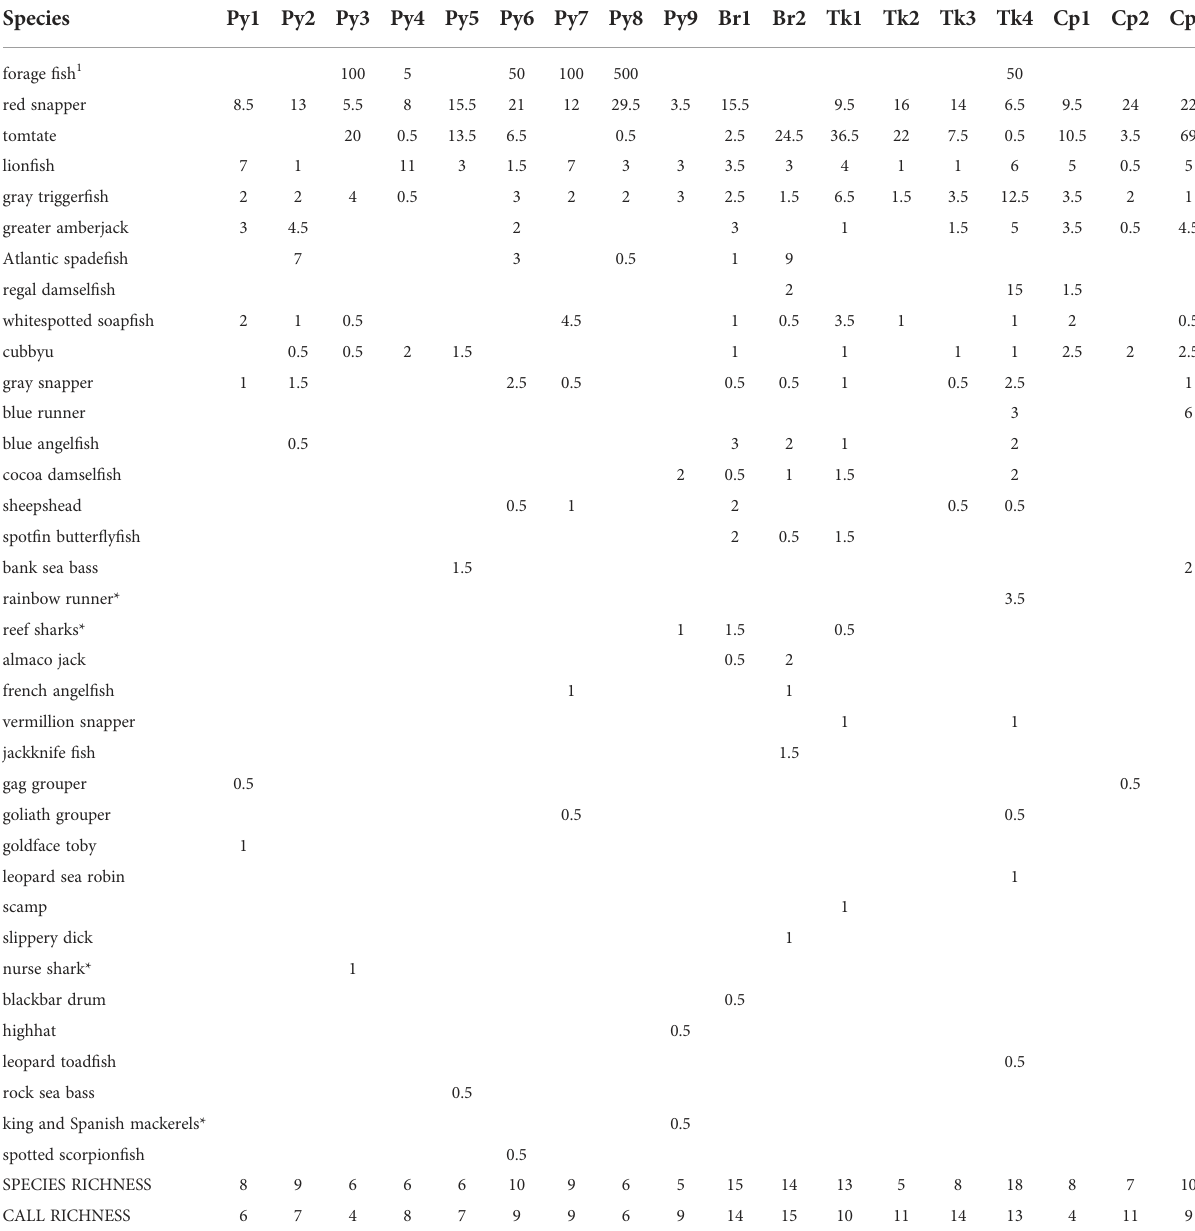
TABLE 2 Fish abundance on reefs (MAXNO, maximum number of fi sh observed in a single video frame, ranked from highest estimated relative abundance 1, to lowest), fi sh species richness, fi sh species diversity, fi sh sound call richness, and fi sh sound call diversity. Rank of each species abundance relative to other